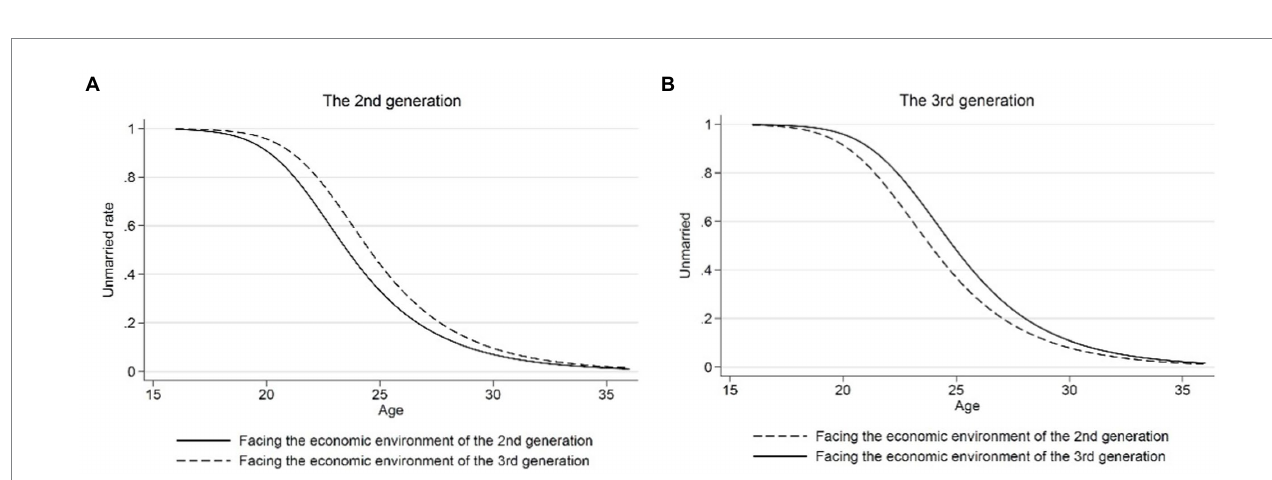
FIGURE 6 The influence of macroeconomic factors on the average age at first marriage. (A) The 2nd generation. (B) The 3rd generation. Macro variables include the moving average growth rate of real GDP of the respondents aged 20 and 29, the unemployment rate, degree of economic openness, and marriage rate of the population aged 20–25 when the respondents are aged